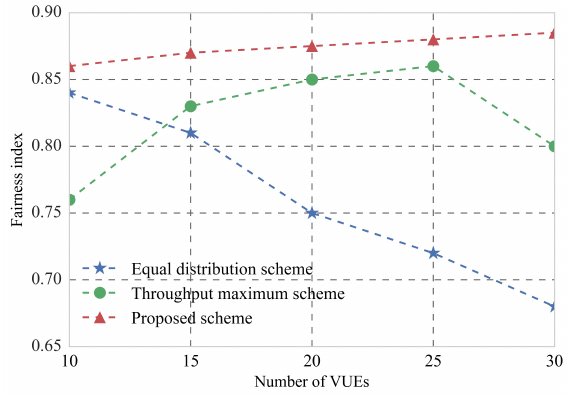
Figure 8. The comparison between the proposed method with existing methods on